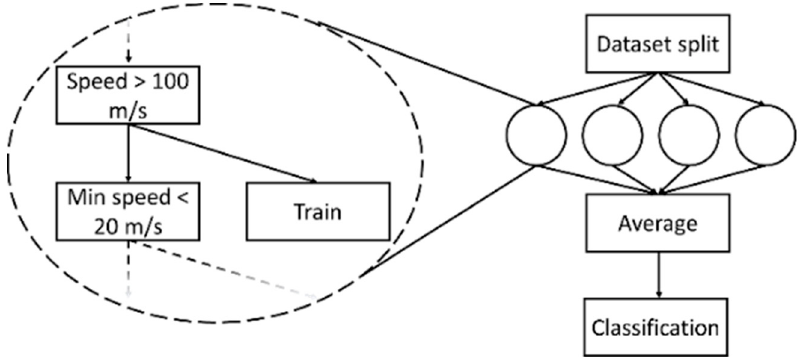
Figure 5. Random Forest high-level scheme.